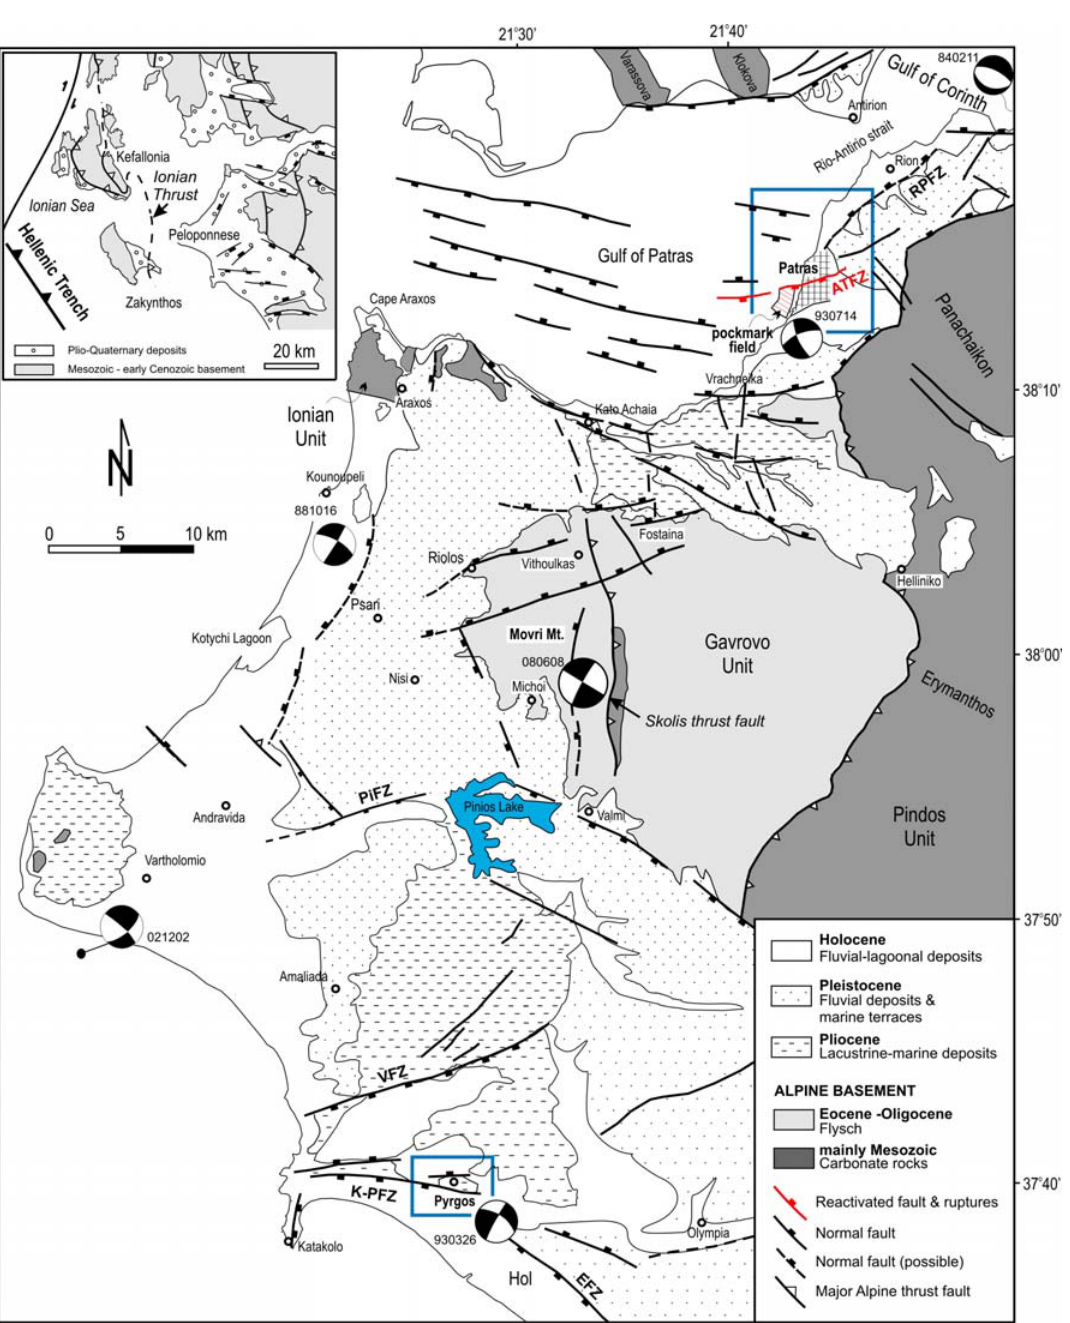
Figure 1. Tectonic setting of the broader study area (ATFZ: Ag. Triada Fault Zone, EFZ: Epitalio fault Zone, RPFZ: Rio–Patra fault Zone, K–PFZ: Katakolo– Pyrgos Fault Zone, PiFZ: Pinios Fault Zone, VFZ: Vounargo Fault Zone, blue frames indicate the study areas, map modified from Koukouvelas et al .